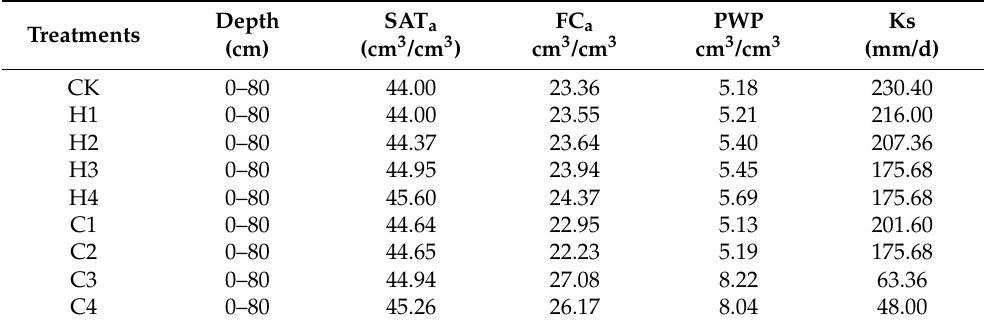
Table 3. Main physical properties of the soil after applying the conditioners.